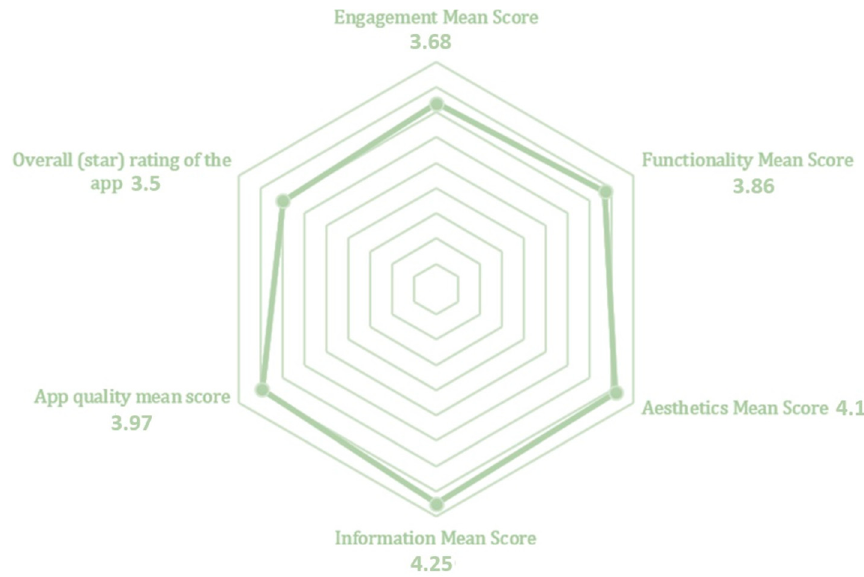
Figure 4. Average score for each section and user perception of the uMARS questionnaire.